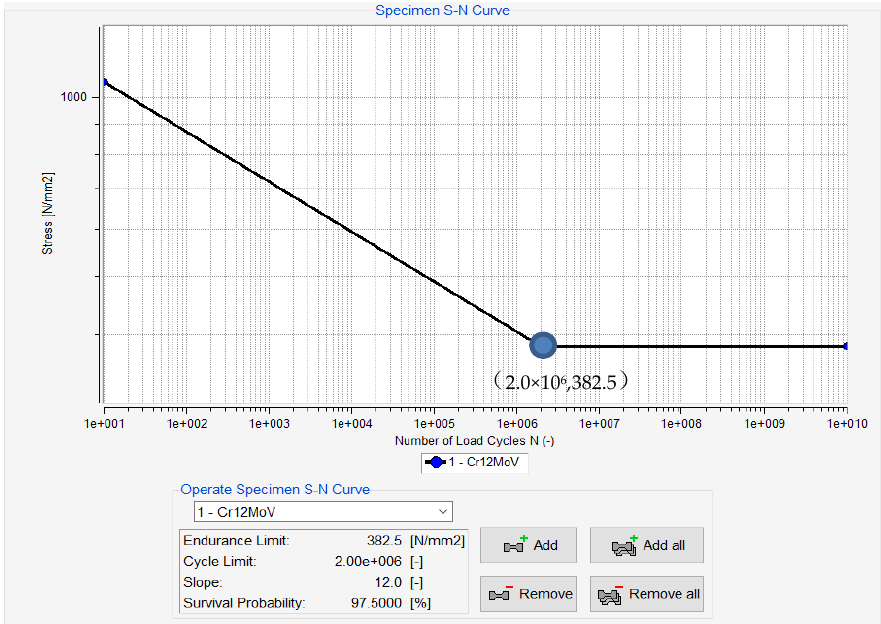
Figure 5. S-N curve of Cr12MoV.